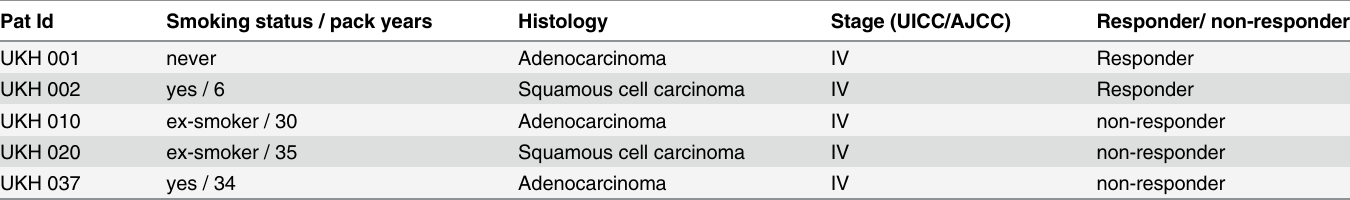
Table 3. Clinical data of second-line